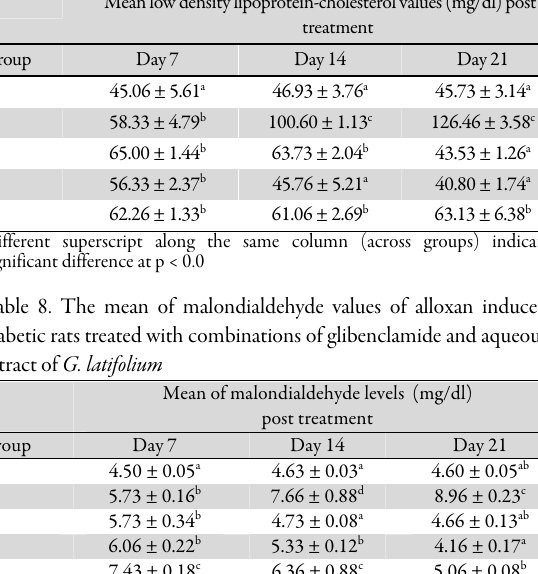
Table 5. The mean of high density lipoprotein-cholesterol values of alloxan induced diabetic rats treated with combinations of glibenclamide and aqueous extract of G. latifolium Mean of high density lipoprotein-cholesterol values (mg/dl)